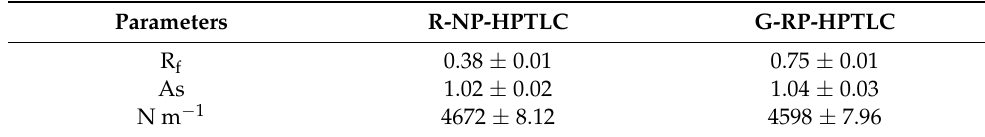
Table 2. System efficiency parameters in terms of retardation factor (R f ), asymmetry factor (As) and number of theoretical plates per meter (N m − 1 ) of TRV for R-NP-HPTLC and G-RP-HPTLC techniques (mean ± SD; n =